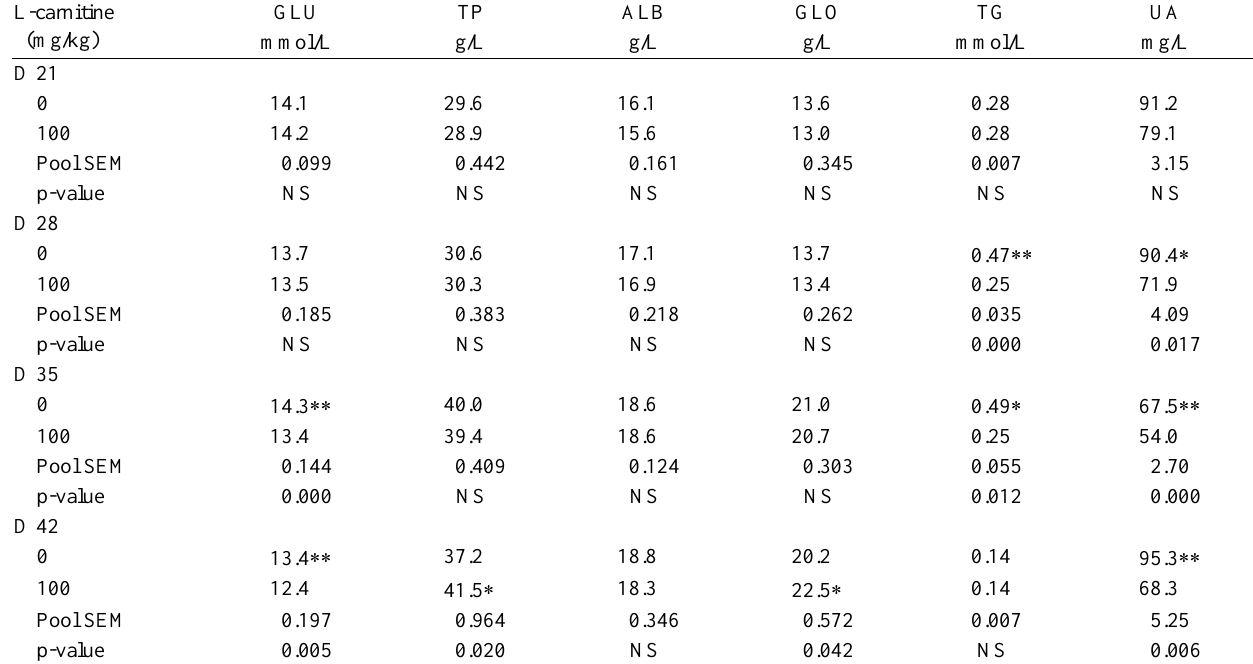
GLU = Glucose, TP = Total protein, ALB = Albumin, GLO = Globulins, TG = Triglyceride, UA = Uric acid. NS = Not significant, * p<0.05 and ** p<0.01.